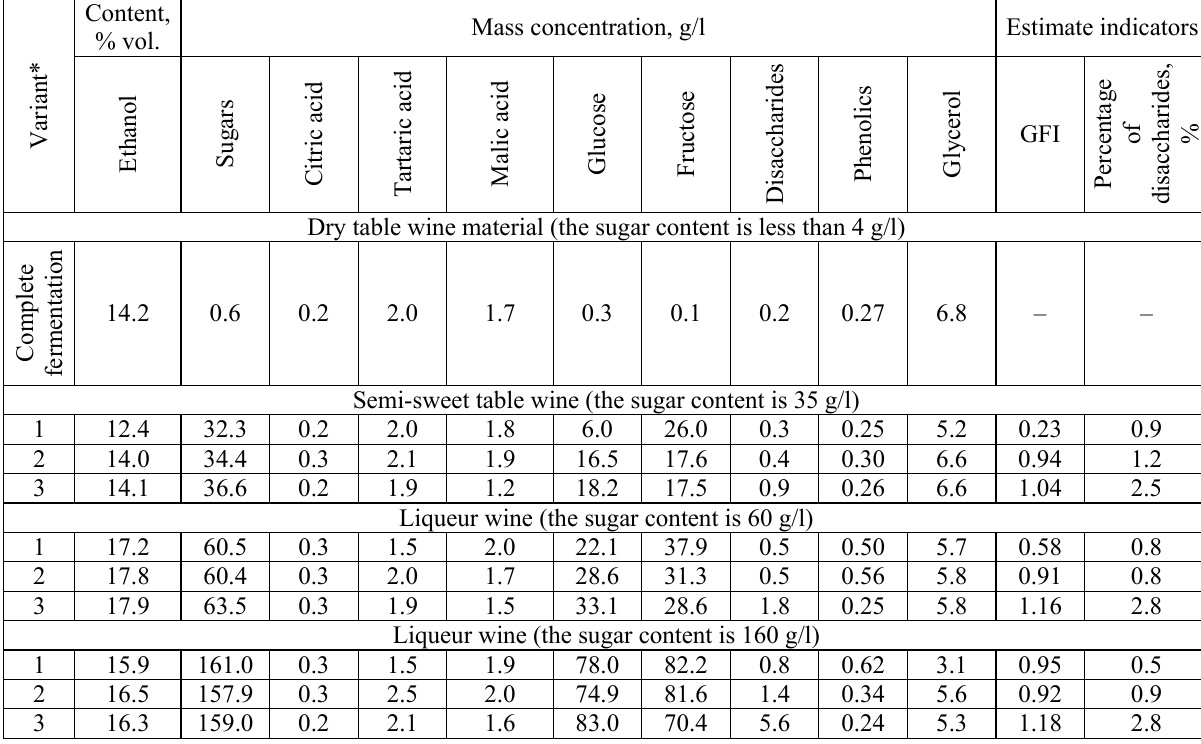
Mass concentration, g/l Estimate